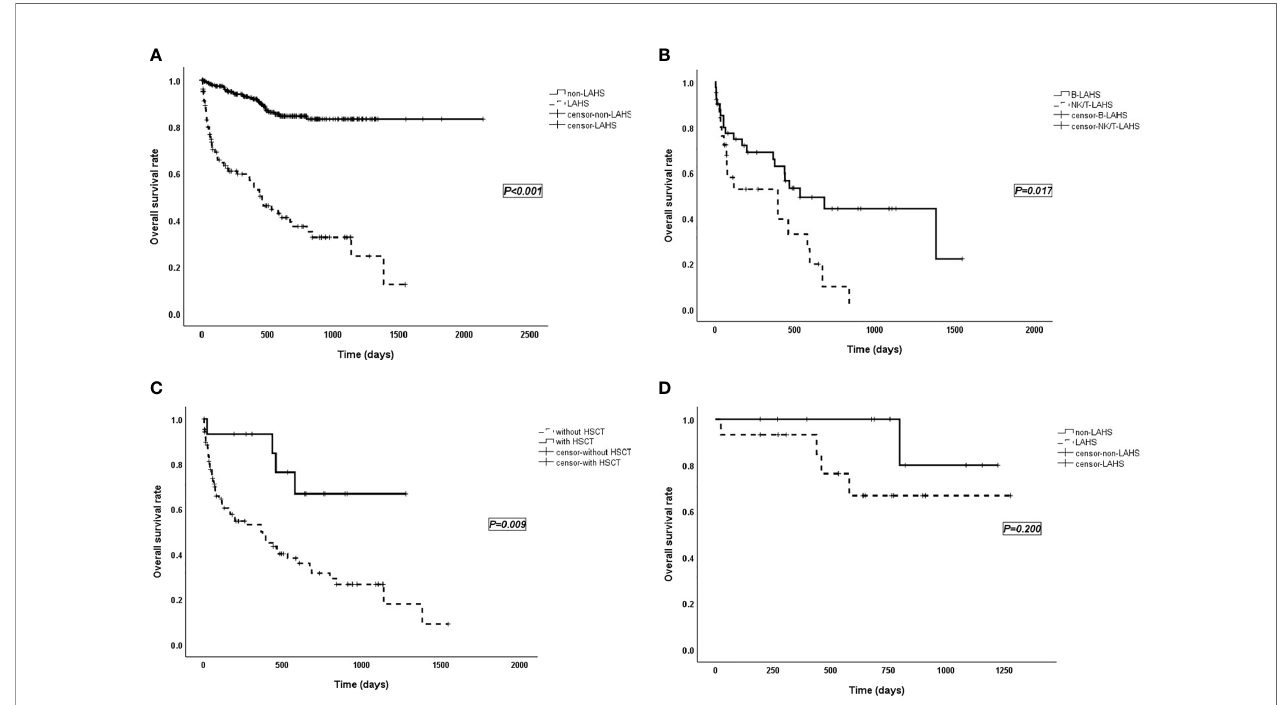
FIGURE 1 | (A) Survival curves of patients with lymphoma without LAHS ( n = 244) vs. with LAHS ( n = 104). “ Non-LAHS ” meanslymphoma without LAHS. (B) Survival curves of patients with B-LAHS ( n = 42)vs. NK/T-LAHS ( n = 26). (C) Survivalcurves of LAHS patients with HSCT ( n = 15) vs. without HSCT ( n = 89). (D) Survival curves of patients received HSCT with lymphoma alone ( n = 11) vs. LAHS ( n = 15). “ Non-LAHS ” meanslymphoma